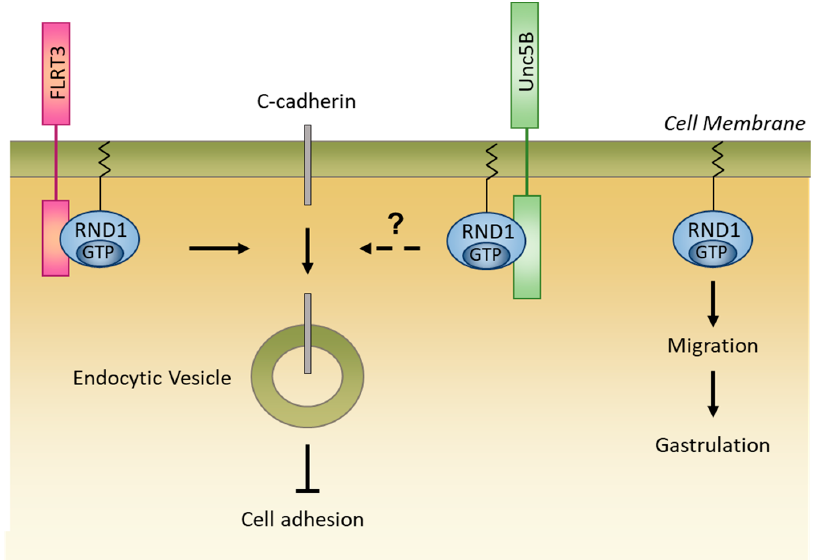
Figure 5. RND1 is involved in adhesion and migration during embryogenesis. In Xenopus embryos, RND1 can bind both the FLRT3 transmembrane protein and the netrin receptor, Unc5B. The association